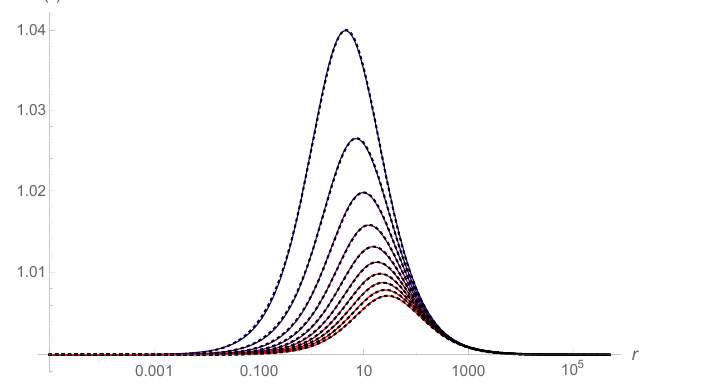
Figure 11 . Comparison between f , for A = 1 (blue) to A = 10 (red), to the (cid:12)tted f app (dotted).